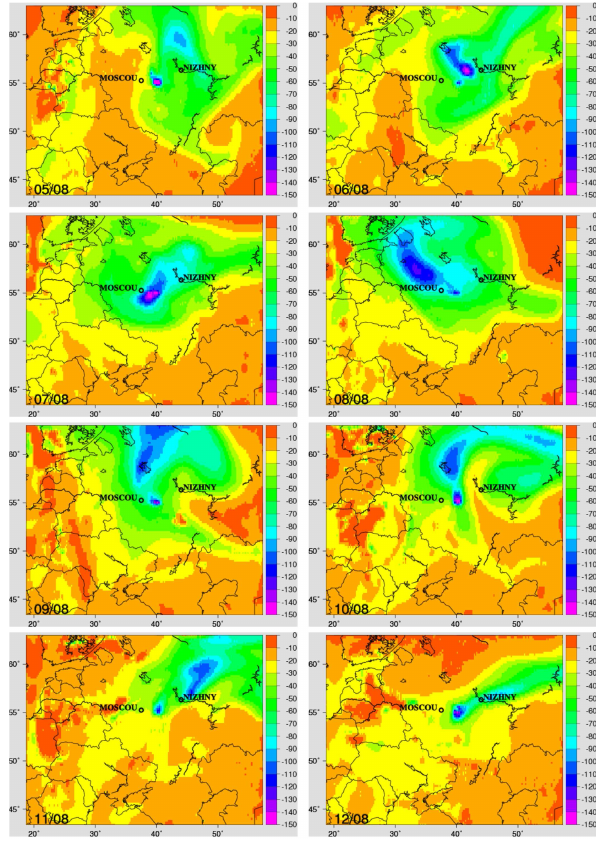
Fig. 8. Impact of the shortwave ADRF on the diurnal-averaged near- surface air temperature (in degrees) simulated for between 5 and 12 August